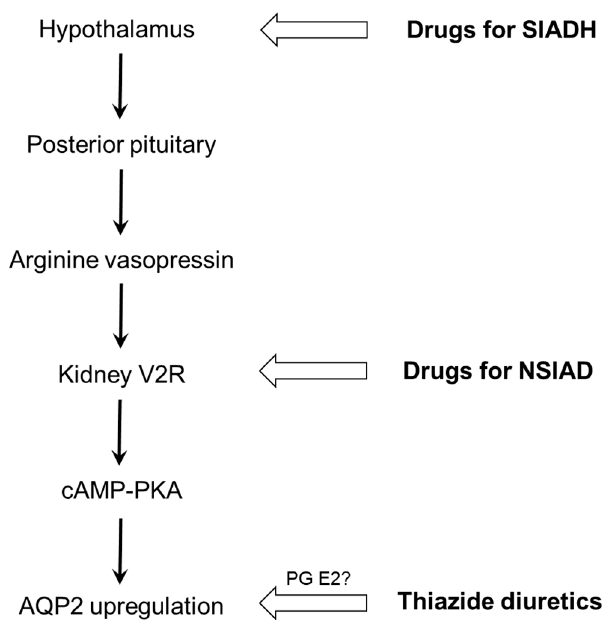
Figure 5. Different levels of action for drug-induced hyponatremia. Drugs that induce SIADH include vincristine and ifosfamide, and representative drugs for NSIAD are haloperidol, sertraline, carbamazepine, and cyclophosphamide. AQP2, aquaporin-2; cAMP, cyclic adenosine monophos- phate; NSIAD, nephrogenic syndrome of inappropriate antidiuresis; PG, prostaglandin; PKA, protein kinase A; SIADH, syndrome of inappropriate antidiuretic hormone secretion. Funding: This work was supported by a grant from the National Research Foundation of Korea (NRF-2018R1D1A1A02047590).